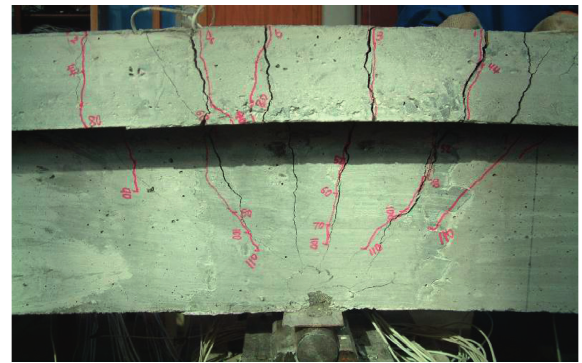
Figure 20: Cracks at the middle support.